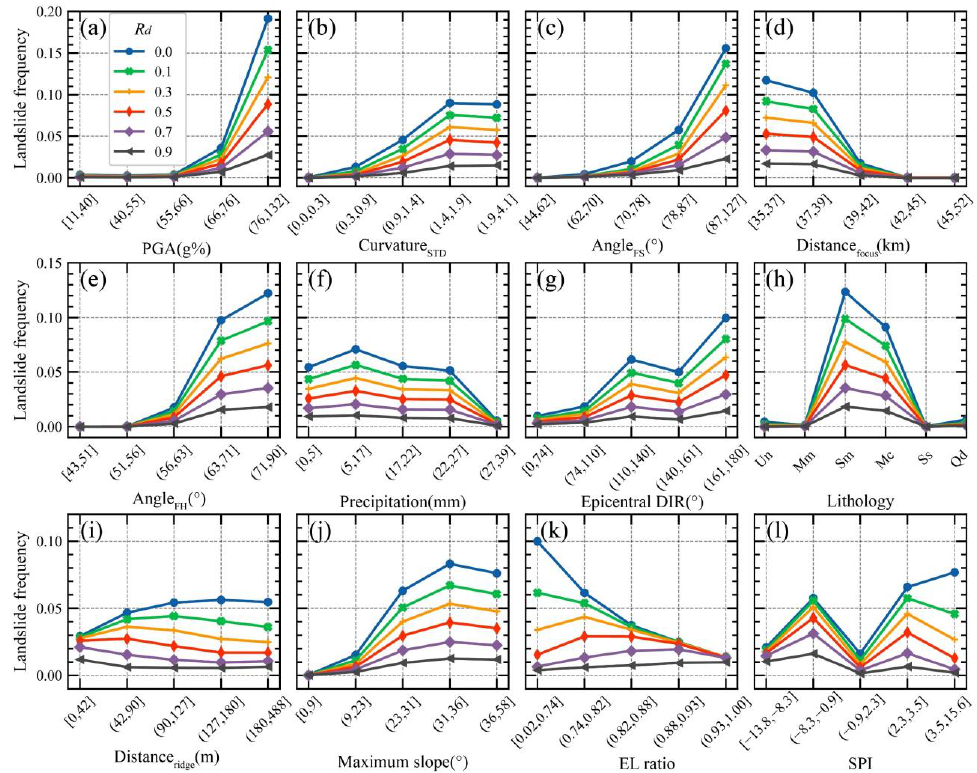
Figure 11. The frequencies of the various parts of the landslide with respect to the landslide influ- encing factors (subfigures a – l ). In Subfigure h , Un (unknown lithology), Mm (marine mudstone), Sm (siliceous mudstone), Mc (marine conglomerate), Ss (Sandstone), and Qd (Quaternary deposits) denote the lithology.